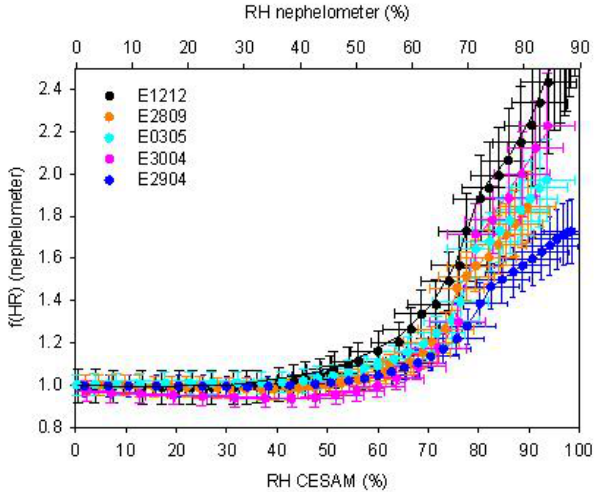
Fig. 9. Scattering growth factor f (RH) as a function of RH within the chamber (bottom axis) and the RH within the nephelometer (up- per